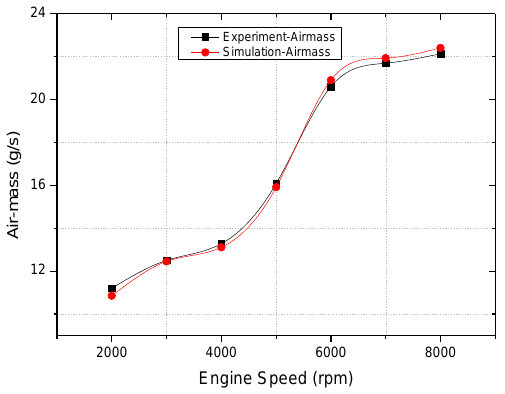
Figure 5. Air mass flow following engine speed.